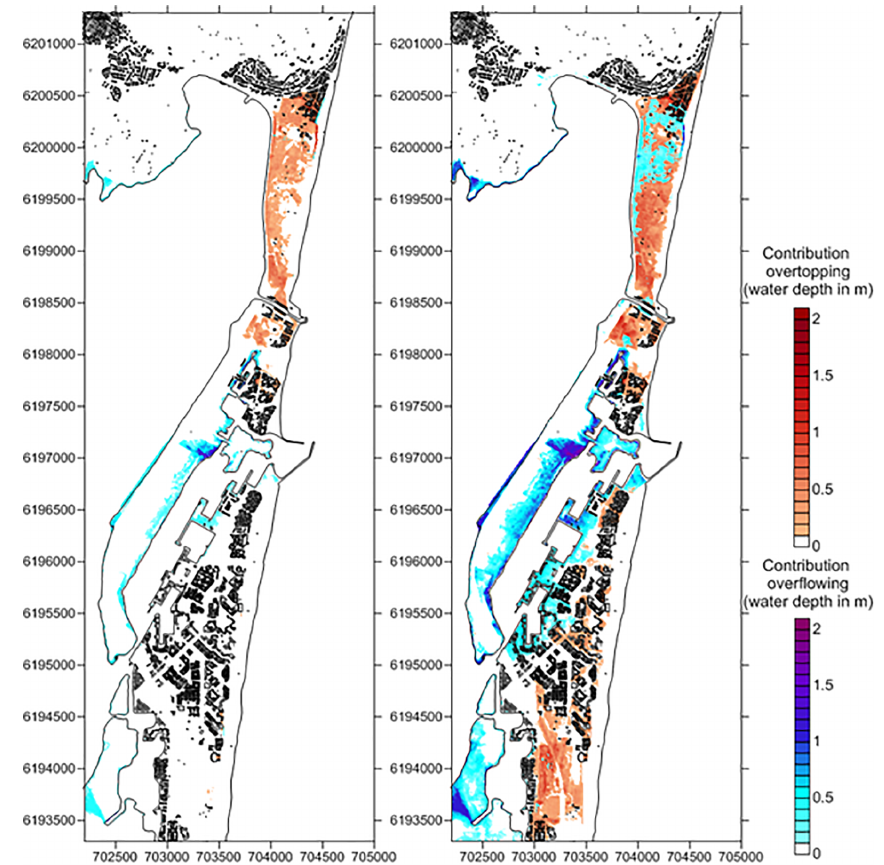
Figure 12. Affected area by overflowing and overtopping for the most impacting 100-year scenarios: ENC1 (environmental contour method